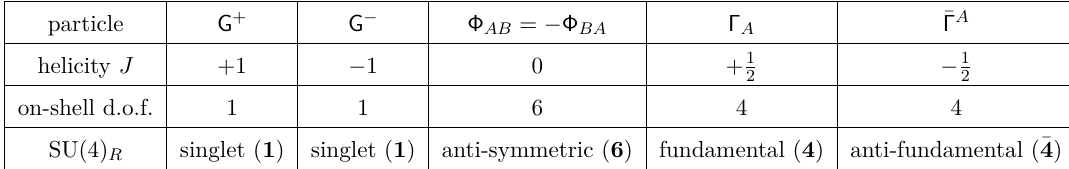
Table 1 . On-shell degrees of freedom of N = 4 SYM. Note that the color index for gauge group is